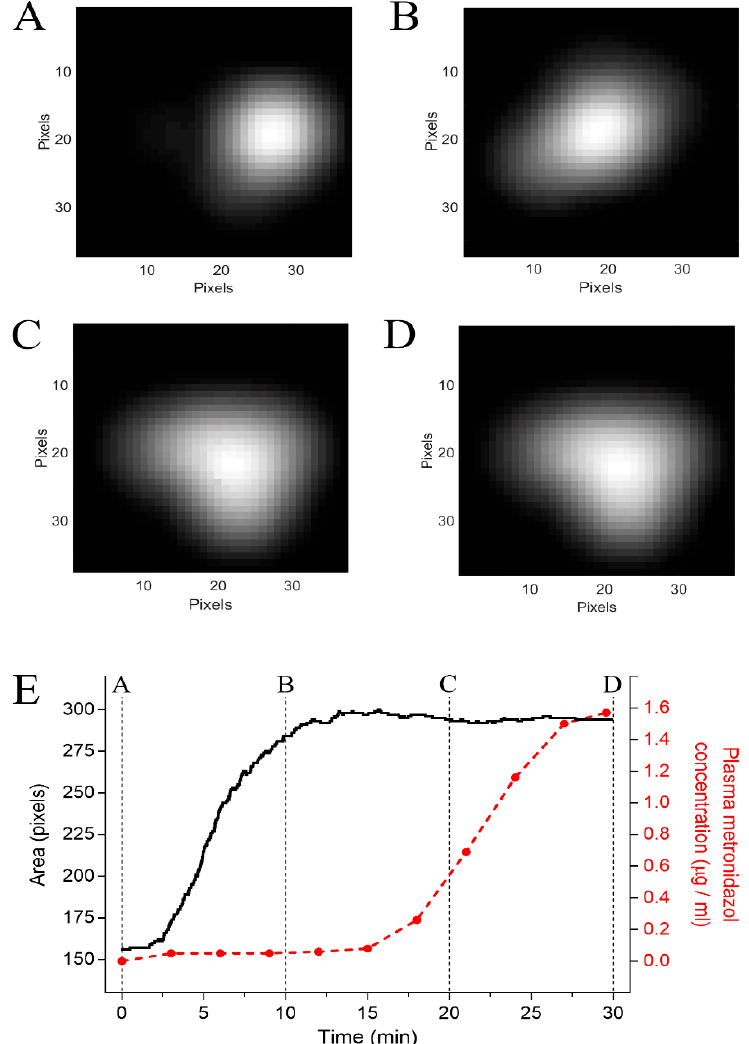
Figure 4. Pharmacomagnetography monitoring of the coated magnetic tablet after administration of the placebo. ( A ) Magnetic images at t = 0 min, ( B ) t= 10 min, ( C ) t= 20 min, and ( D ) t = 30 min after coated magnetic tablet administration. ( E ) Quantification of the magnetic area and metronidazole concentration, the dotted lines indicate the time points in which A, B, C, and D were